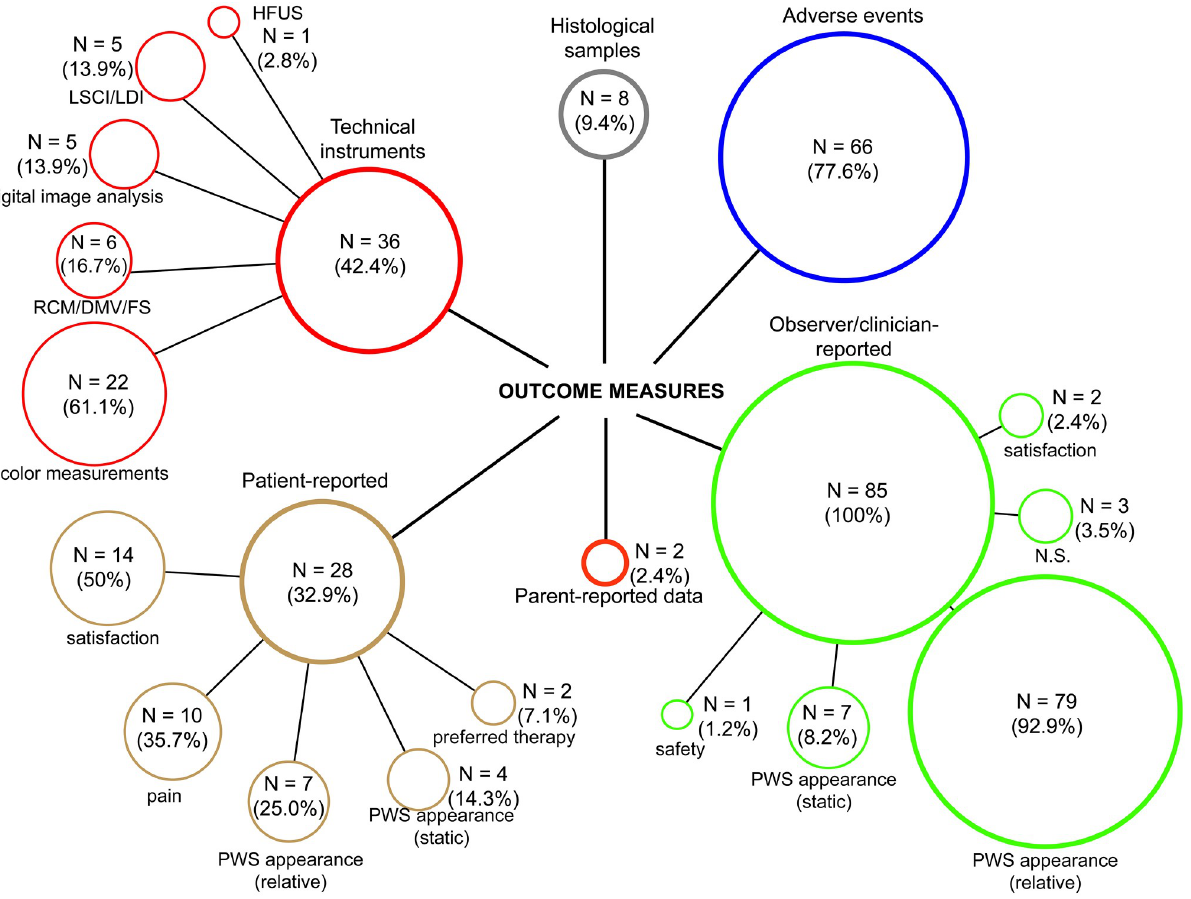
Fig 3. Stratification of all outcome measures. Note that the secondary percentages are relative to the primary variable and that their sum can exceed 100% as single studies assessed multiple outcomes (e.g., some studies used both a relative and static measure of treatment efficacy). Abbreviations: DMV , depth measuring videomicroscopy; FS , fluorescence spectrometry; HFUS , high-frequency ultrasound; LDI , laser Doppler imaging; LSCI , laser speckle contrast imaging, NS , not specified; PWS , port wine stain; RCM , reflectance confocal microscopy.